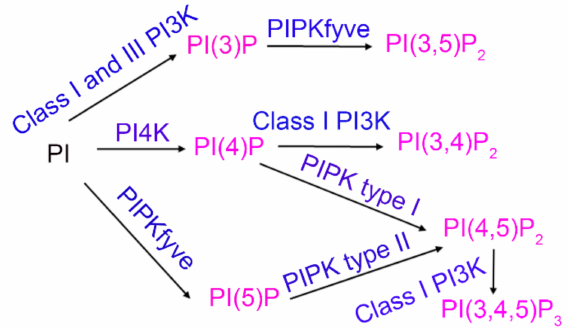
Figure 1. Generation of seven phosphoinositides. Phosphatidylinositol (PI) undergoes phospho- rylation at 3, 4, 5-free hydroxyl groups and generates seven distinct PIPs. Class I phosphoinosi- tide 3-kinase (PI3K) phosphorylates PI to PI(3)P, PI(4)P to PI(3,4)P 2, and PI(4,5)P 2 to PI(3,4,5)P 3 . Phosphoinositide 4-kinase (PI4K) phosphorylates PI to PI(4)P. Phosphatidylinositol 3-phosphate 5-kinase (PIKfyve) phosphorylates PI to PI(5)P and PI(3)P to PI(3,5)P 2 . Type I phosphatidylinosi- tol 4-phosphate 5-kinase (PIPKI) phosphorylates PI(4)P to PI(4,5)P 2 . Type II phosphatidylinositol 5-phosphate 4-kinase (PIPKII) phosphorylates PI(5)P to PI(4,5)P 2 . Pink, PIPs; Blue,